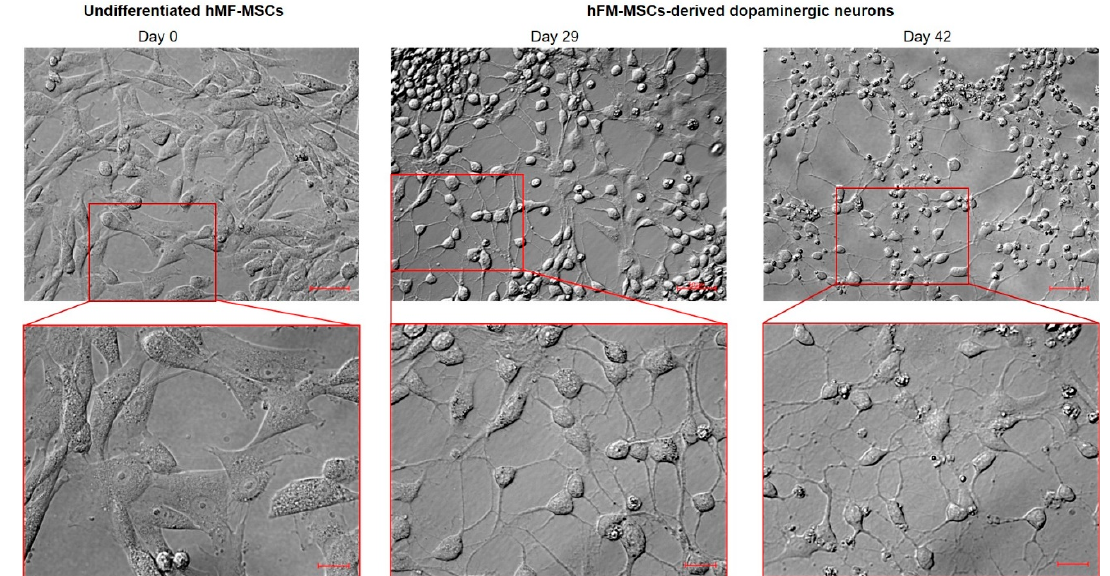
Figure 4. Morphological analysis of hFM-MSC during the differentiation process into DA neuron-like cells. Brightfield images of hFM-MSCs at 0, 29, and 42 days of the differentiation process. Note that differentiated cells express between two and six neurites. Cells have been observed with AxioVert A1 using plasDIC–Plan Neofluar. Original Magnification: 20×, scale bar 50 μ m. Red rectangles represented enlarged areas (40×), scale bar 20 μ m. The images are representative of three independent experiments.